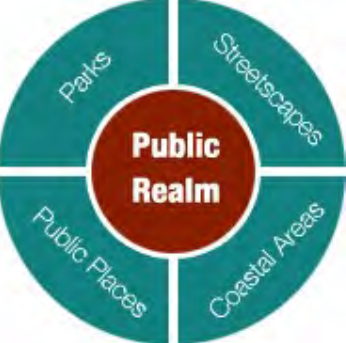
Figure 3. (Public realm main